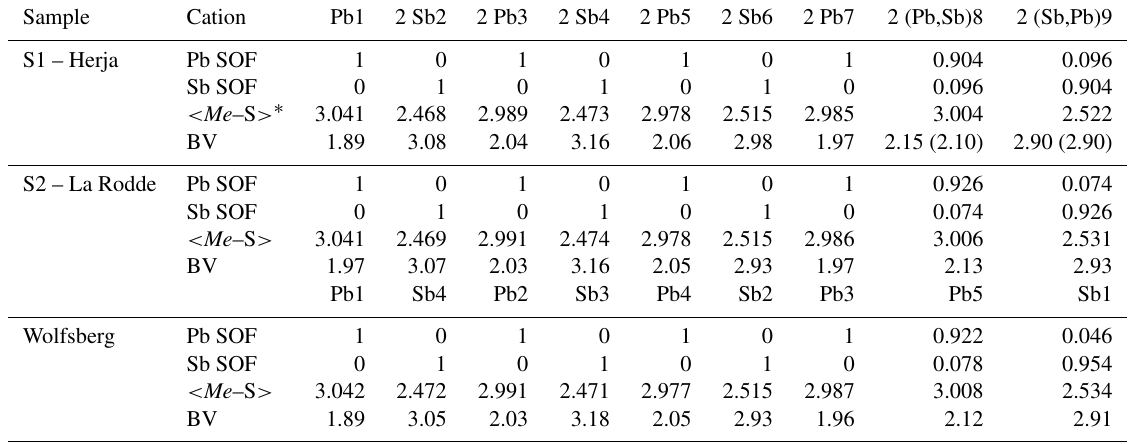
Table 5. Lead-versus-Sb distribution (SOF), average bond distances ( < Me –S > ), and cation bond valences (BVs) in the studied samples of semseyite. For the sake of comparison, cation distribution of semseyite from Wolfsberg after Matsushita (2018) is shown. Sample